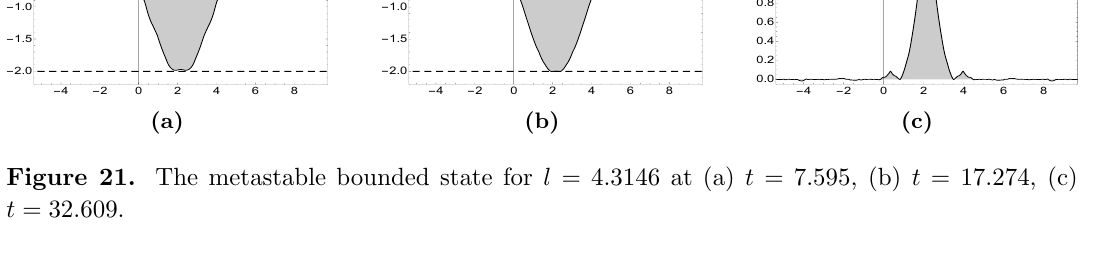
> l . In (cid:12)gure 21 we plot a crit min